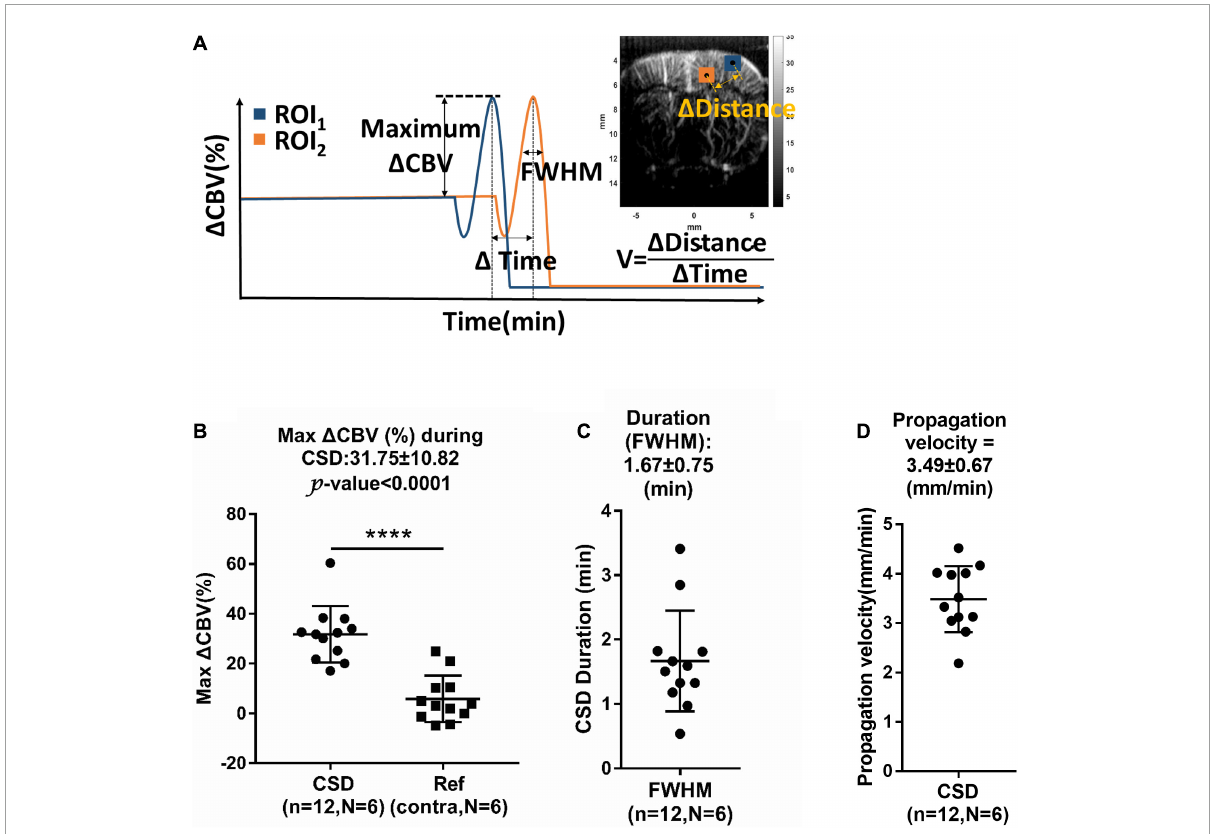
FIGURE4 (A) Measurement of relative changes in CBV ( (cid:49) CBV), full-width half-magnitude (FWHM) of duration, and propagation velocity (V) of hemodynamic changes during CSD. Summarized data of CSD-induced maximum increase in (B) (cid:49) CBV, (C) FWHM, and (D) propagation rate. n: number of CSD; N: number of animals. Data are reported as means ± SD. **** P < 0.0001 between